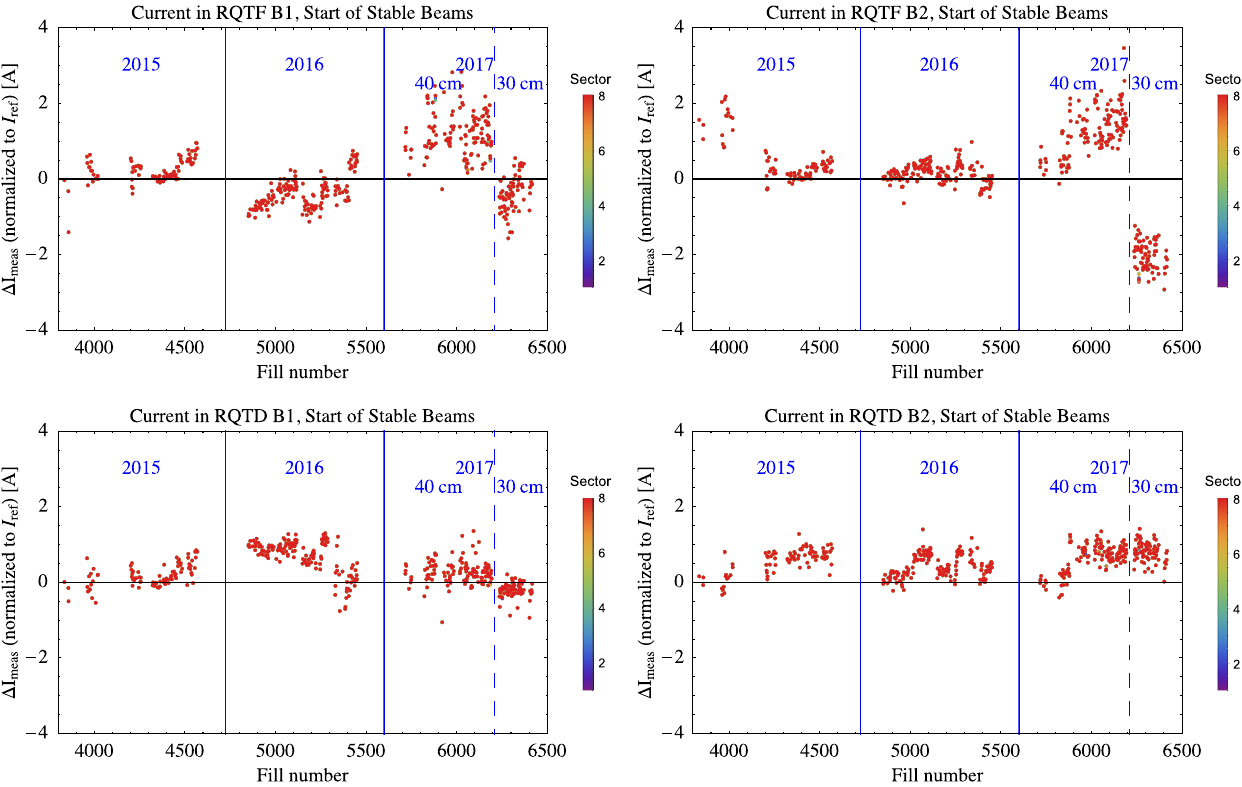
FIG. 7. Fill to fill differences in the current of the RQTF (top) and RQTD (bottom) circuits at the start of stable beams. Left: Beam 1, right: Beam 2, the different sectors are shown in color code, but due to their similarity for each family they lie on top of each